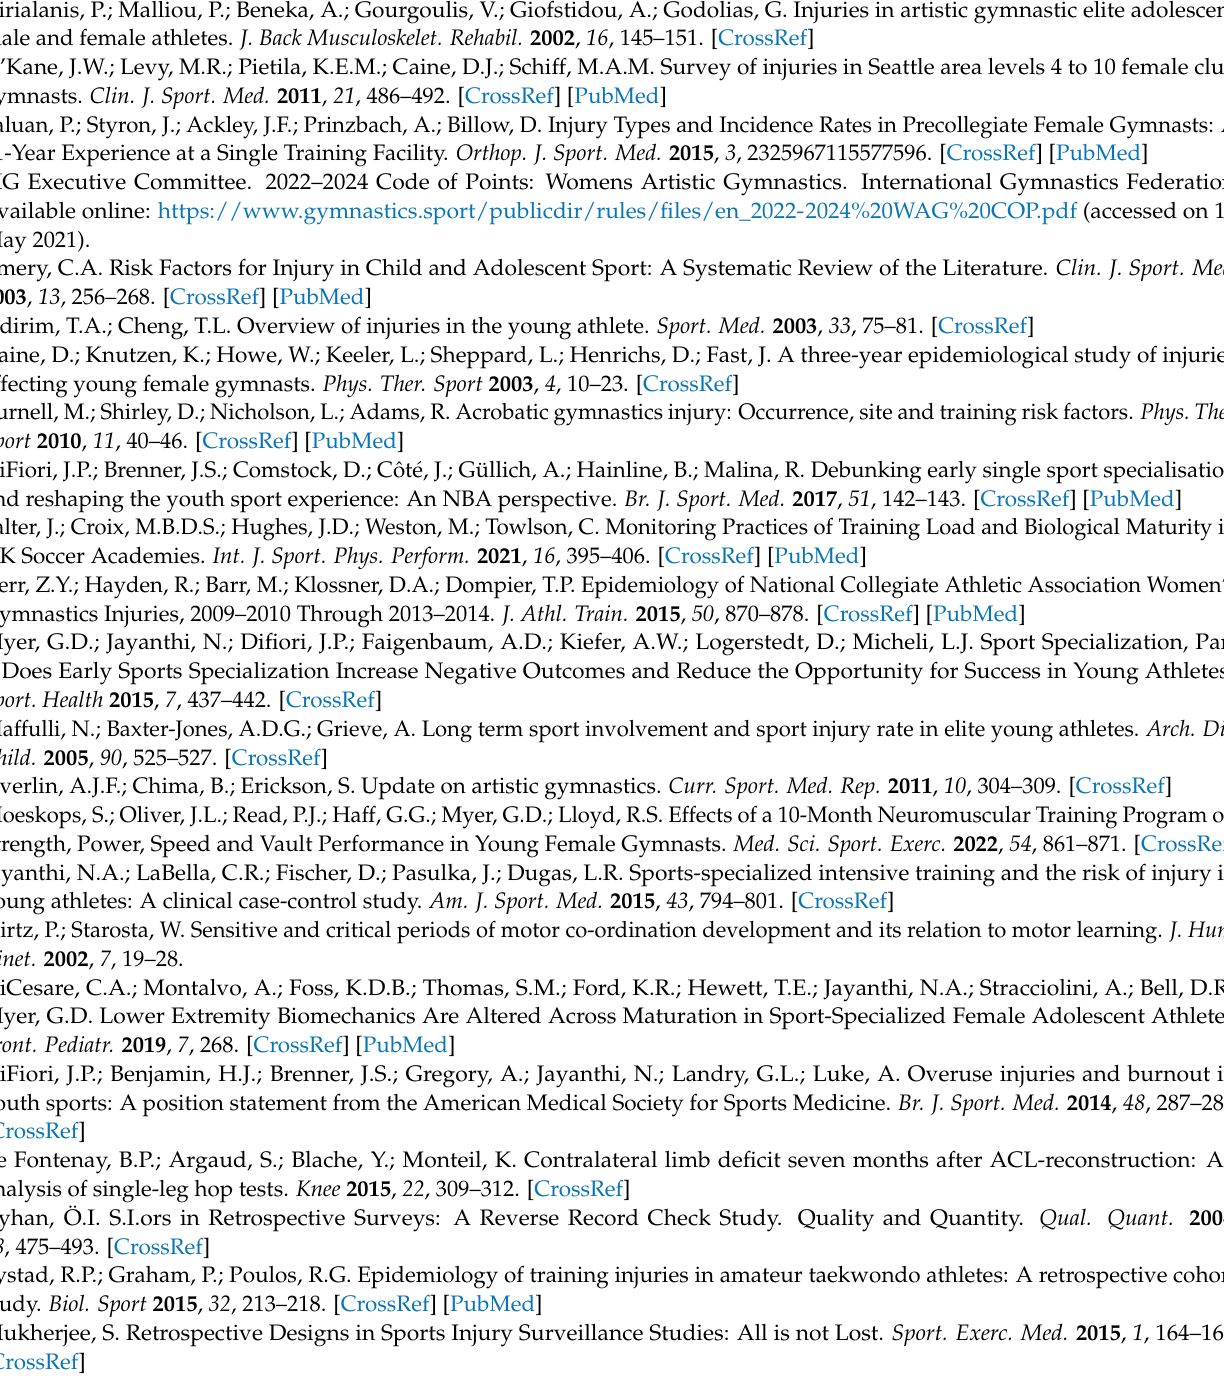
FIG Executive Committee. 2022–2024 Code of Points: Womens Artistic Gymnastics. International Gymnastics